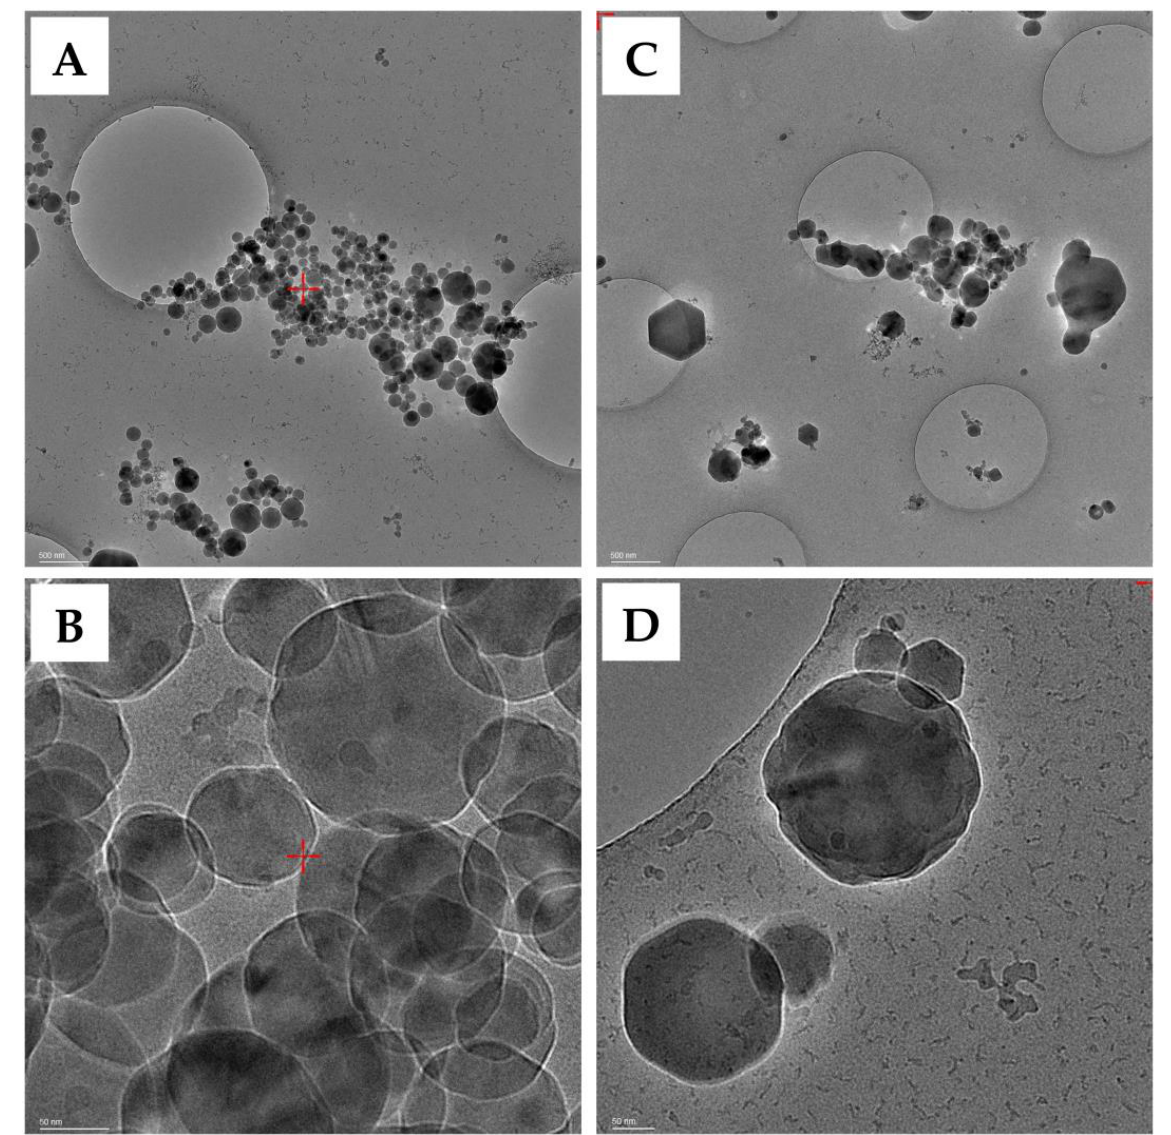
Figure 3. Ultrastructure investigation by cryo-EM of SFNs ( A , B ) and c RGD-SFNs-NDI-1 ( C , D ). Scale bar: 500 ( A , C ) and 50 ( B , D ) nm. Table 4. Expression of integrin subunits in U373 compared to D384 cells. Data are expressed as ∆ Cq. α v